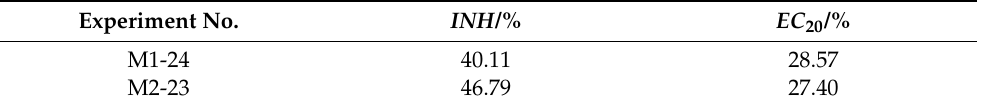
Table 4. Inhibition of aqueous phase ( INH ) and EC values ( EC 20 ) obtained by ecotoxicity tests for the aqueous phase in experiments M1-24 and M2-23 by Vibrio fischeri . Experiment